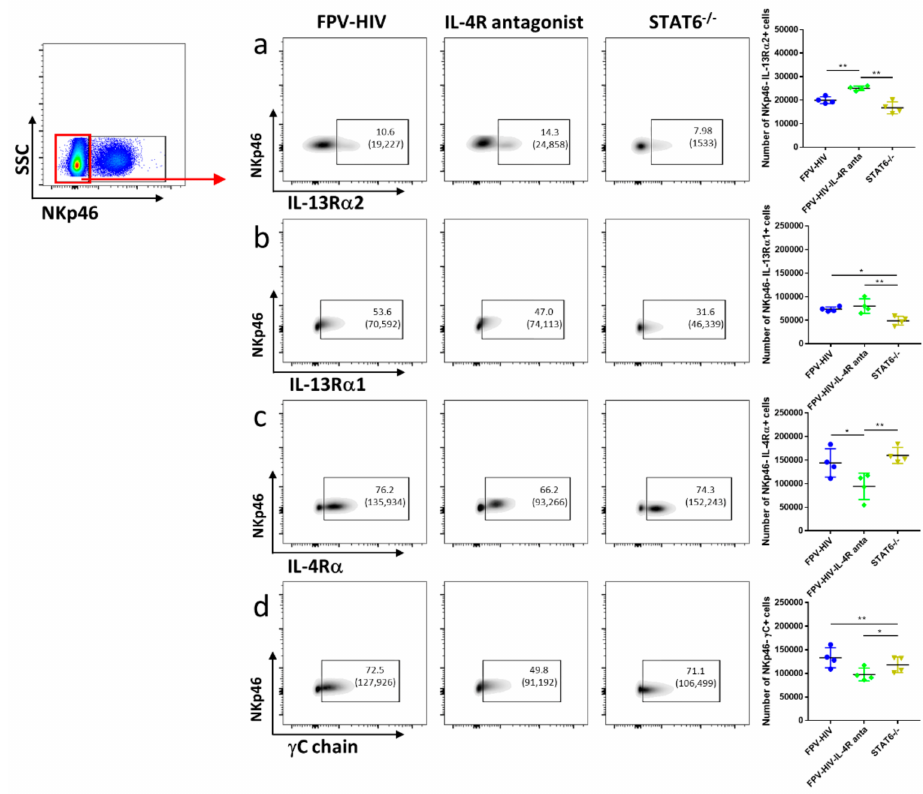
Figure 3. Evaluation of lung lineage − IL-33R/ST2 − NKp46 − ILC1/ILC3 expressing IL-13R α 2, IL- 13R α 1, IL-4R α , and γ C following vaccination under permanent vs. transient inhibition of STAT6. WT BALB/c and STAT6 − / − mice on BALB/c background (n = 4) were immunized intranasally with FPV-HIV-IL-4R antagonist adjuvanted or FPV-HIV unadjuvanted vaccines, respectively. Color coded vaccine groups represent: blue, WT BALB/c given FPV-HIV (control); green, WT BALB/c given FPV-HIV-IL-4R antagonist vaccine (which represents transient IL-4/IL-13/STAT6 signaling inhibition condition); and yellow, STAT6 − / − given FPV-HIV (which represents permanent STAT6 signaling inhibition condition). Lung NKp46 − ILC1/ILC3 were gated as CD45 + FSC low SSC low lineage − IL-33R/ST2 − NKp46 − cells. The FACS plots in each panel indicate the percentage of NKp46 − ILC1/ILC3 expressing IL-13R α 2 ( a ), IL-13R α 1 ( b ), IL-4R α ( c ), and γ C chain ( d ). The bracket below the cell percentage indicates the number of cells in each gate. Graph in each panel represents the number of NKp46 − ILCI/ILC3s expressing the different receptors back calculated to CD45 + population, as described in the materials and methods at (24 h post vaccination). The error bars represent the mean and standard deviation (s.d.). The p values were calculated using one-way ANOVA using Tukey’s multiple comparisons test and unpaired t -test. * p < 0.05, ** p < 0.01. Experiments were repeated a minimum of 3